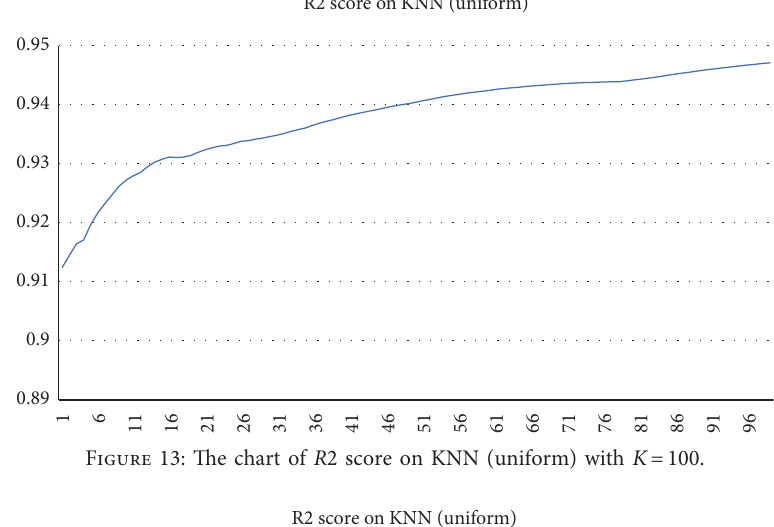
Figure 12: The visualization of MSE on KNN (distance) with K � 100.